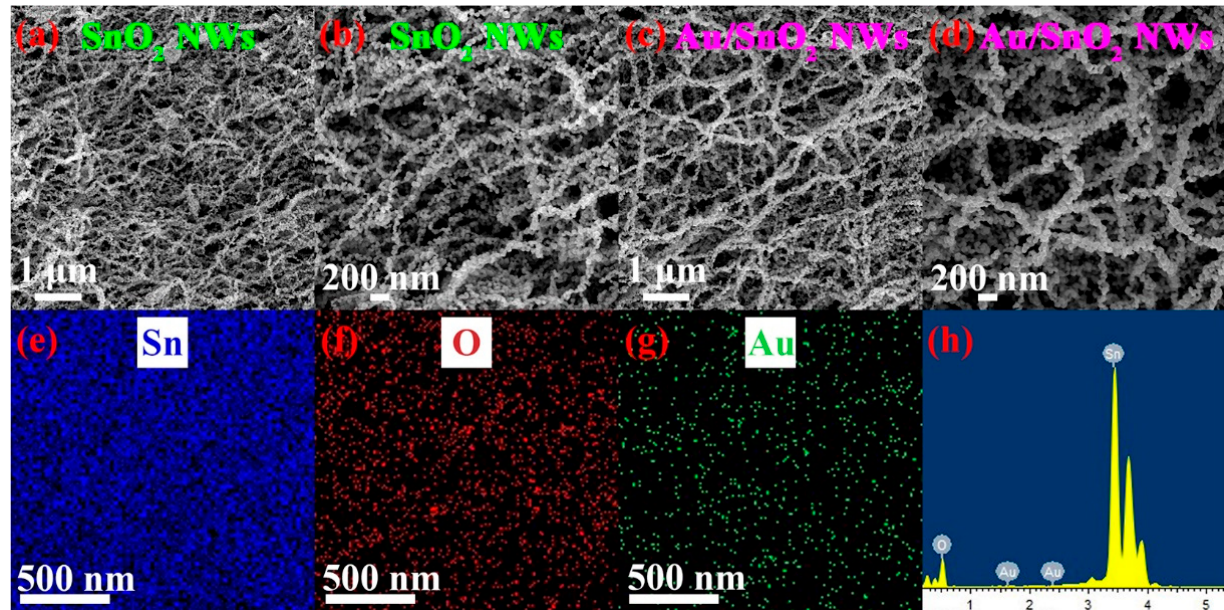
Figure 2. Low- and high-magnification SEM images of ( a , b ) SnO 2 NWs and ( c , d ) Au/SnO 2 NWs. ( e – g ) EDS elemental mapping images of Au/SnO 2 NWs in a certain region of ( c ). ( h ) EDS spectrum of Au/SnO 2 NWs in a certain region of ( d ).